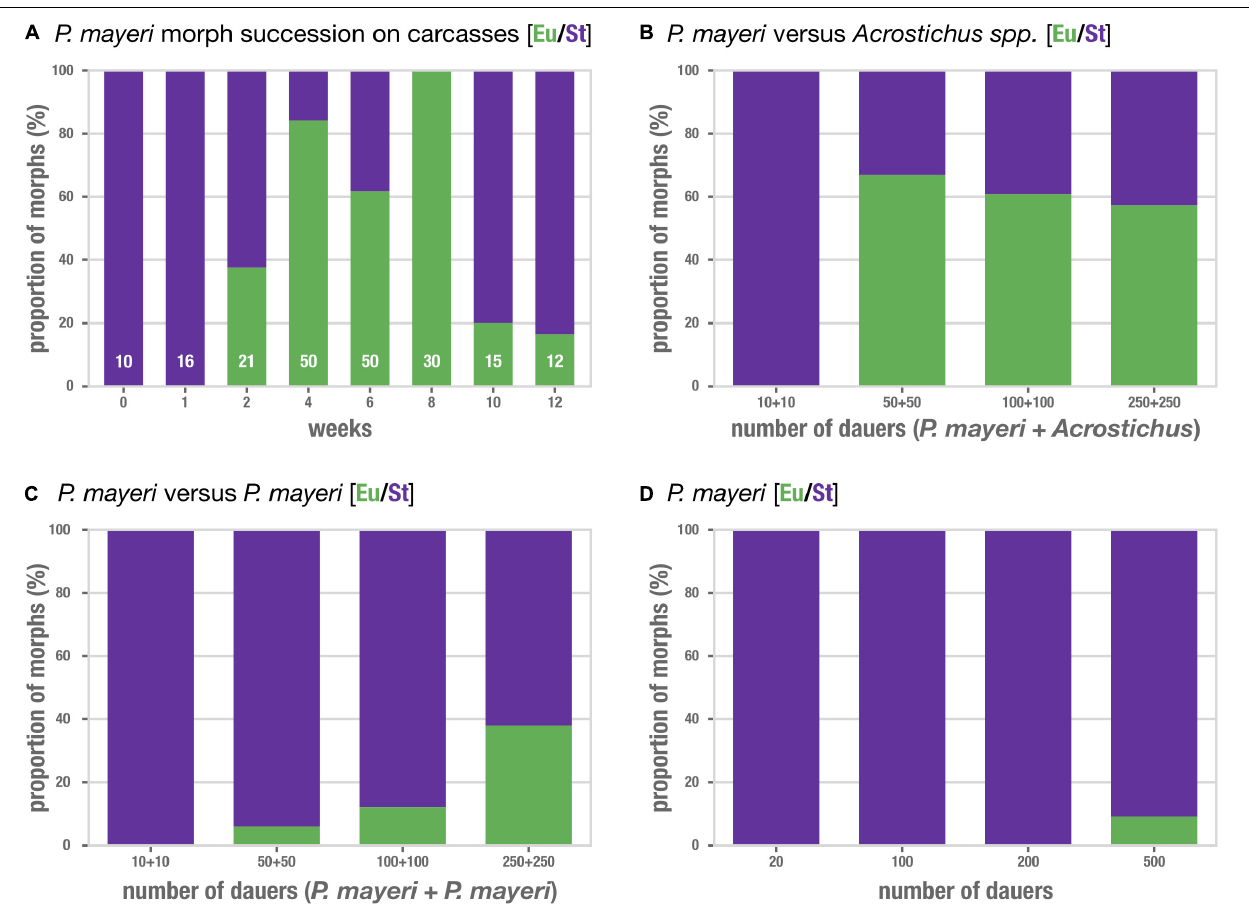
FIGURE 3 | Pristionchus mayeri develops the predatory morph in populations dense with competitors. (A) Succession of mouth-form ratios of P. mayeri on beetle carcasses co-infested with Acrostichus. N is shown in white for each time point; the range reflects the variability of number of individuals present as displayed in Figure 2B . The number of predators increases as the density on the carcass increases ( t = 2–8 weeks). Though, when the population is low at t = 0, 1, 10, and 12 weeks, the prevalence of predators decreases. Competition assays (B–D) using dauer lines from the worms observed in panel (A) . (B) P. mayeri vs. Acrostichus in increasing density of dauers shows an increase in the predatory morph. Fisher’s exact test on summed Eu counts against the respective dauer density as shown in panel (D): p < 0.05 for densities 50:50, 100:100, and 250:250. N = 100 per bar, 10 strains of each competitor in various combinations. (C) P. mayeri vs. P. mayeri from different carcasses in increasing density of dauers. Fisher’s exact test on summed Eu counts against the respective dauer density as shown in panel (D): p < 0.05 for densities 100:100 and 250:250. N = 100 per bar, 10 strains of each competitor in various combinations. (D) Control P. mayeri assays in which singled strains were grown at the same densities as in the competition assays of (B,D) . N = 100 per bar, 10 strains